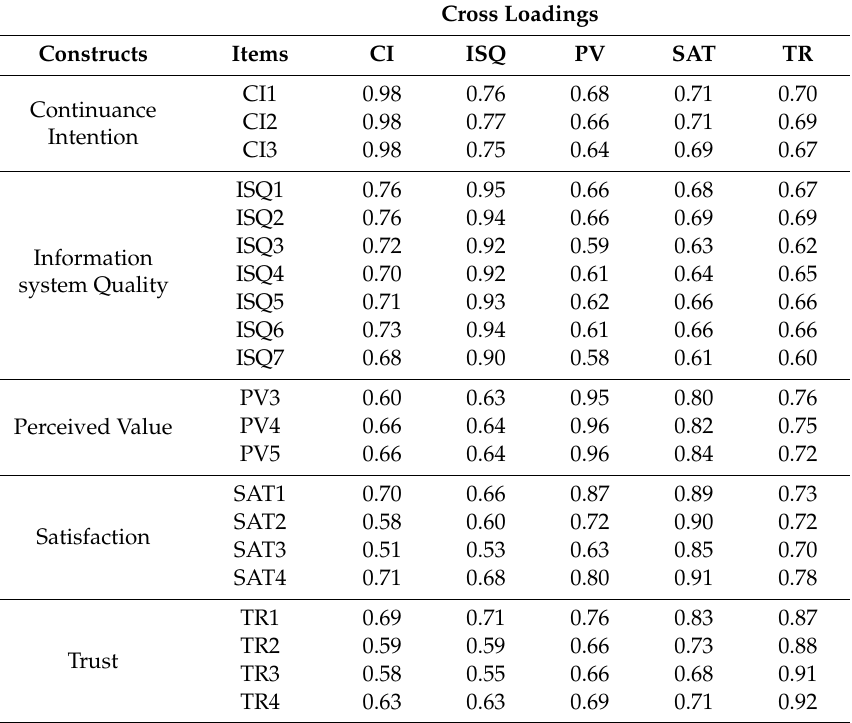
Table A2. The Result of cross